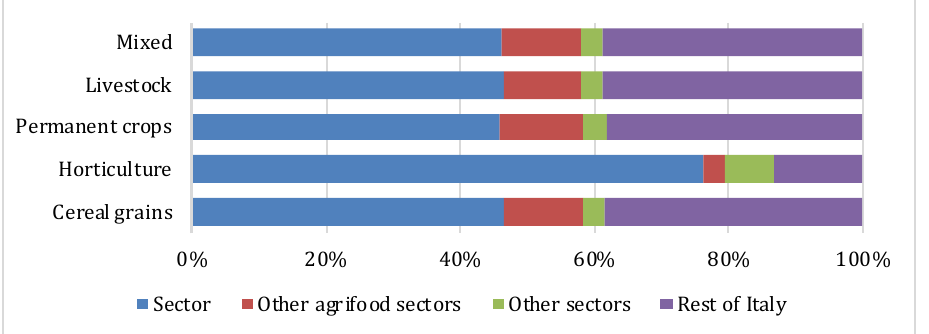
Figure 2. Share of Basilicata’s agricultural sectors to the various “blocks” of the production area.